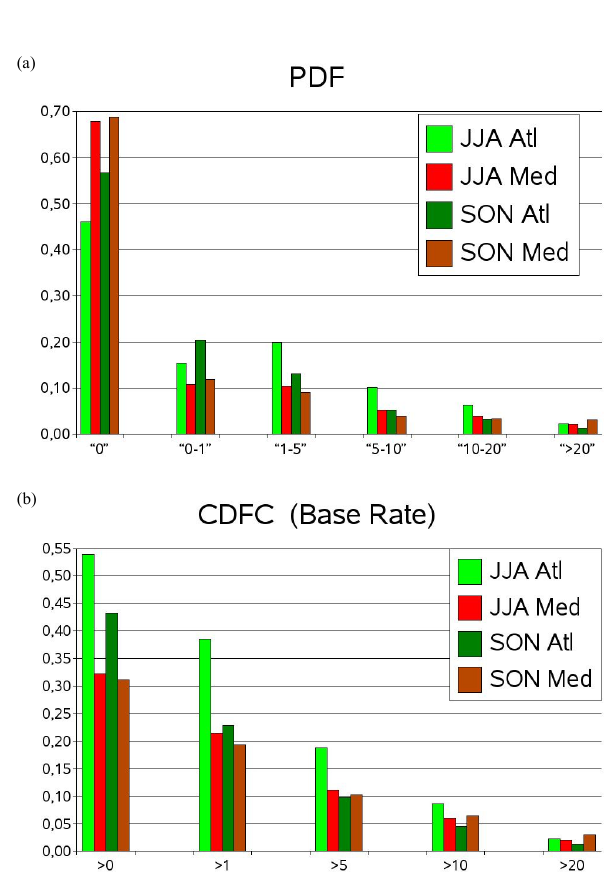
Figure 2. (a) Precipitation distribution (probability density function (PDF)) and (b) complementary cumulative distribution function (CDFC) or event frequencies of occurrence (base rates) along different precipitation intervals (0, 0-1, 1-5, 5-10, 10-20 and more than 20 mm) and thresholds (0, 1, 5, 10 and 20 mm) respectively for summer (June-July-August (JJA)) and autumn (September-October-November (SON)) 2007 precipitation over Mediterranean (light red for summer, dark red for autumn) and Atlantic (light green for summer, dark green for autumn) areas.